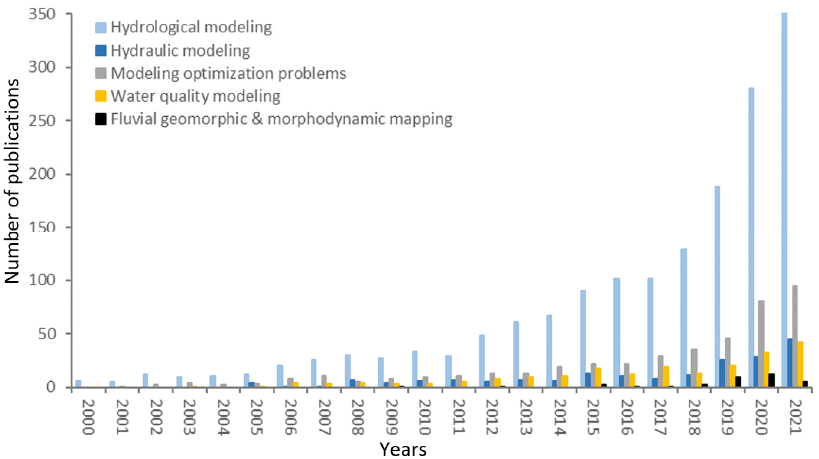
Figure 1. The yearly number of publications found in Web of Science (2000–2021) on GeoAI and machine learning applications in the different hydrological subfields.